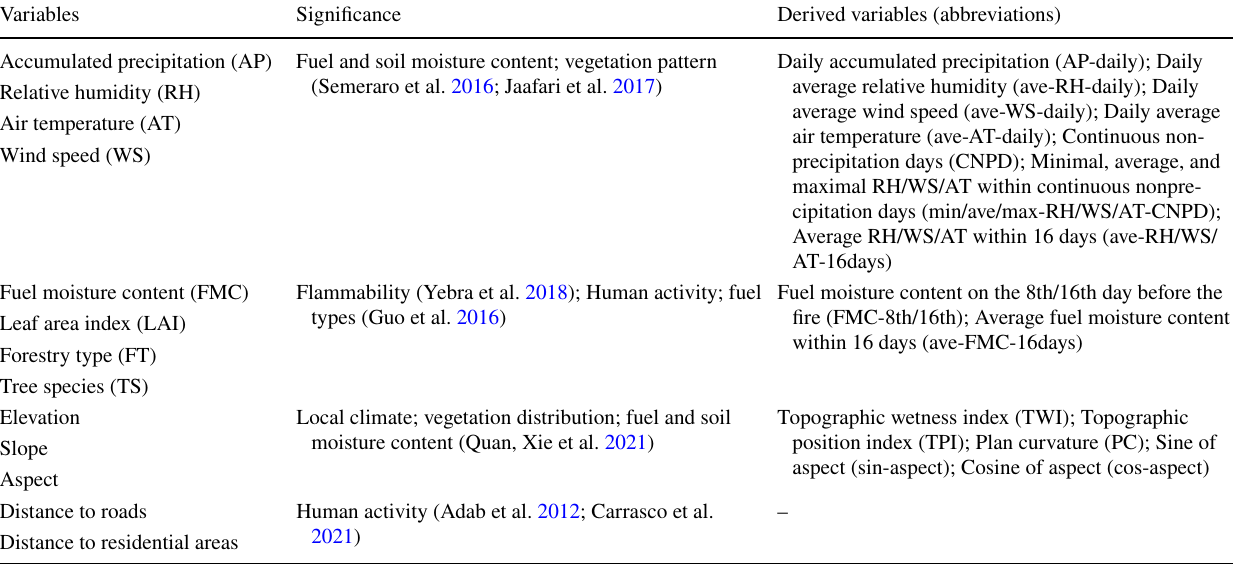
Table 1 Source and significance of the variables used in this study